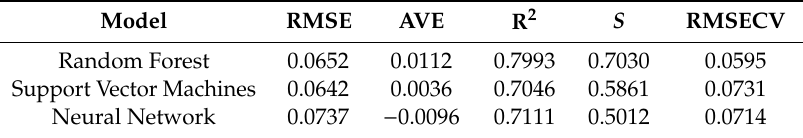
Figure 5. Out-of-bag (OOB) error obtained in the prediction defoliation model of Maritime pine stands in a decline process in the variance, reached a local optimum, including the 80% of the data in the training set. Importance of environmental predictors in predicting the presence or absence of defoliation in southeastern Andalusia (Spain). Importance is measured by Random Forest (RF). Table 2. Summary of the statistical criteria computed for the evaluation of regression models used to study the defoliation of Pinus pinaster forests in Sierra de Baza (Southern Spain, Andalusia-Granada). Root Mean Squared Error (RMSE); average error (AVE), R-squared (R 2 ), Spearman´s ρ (S) and root-mean-squared error of the cross-validation